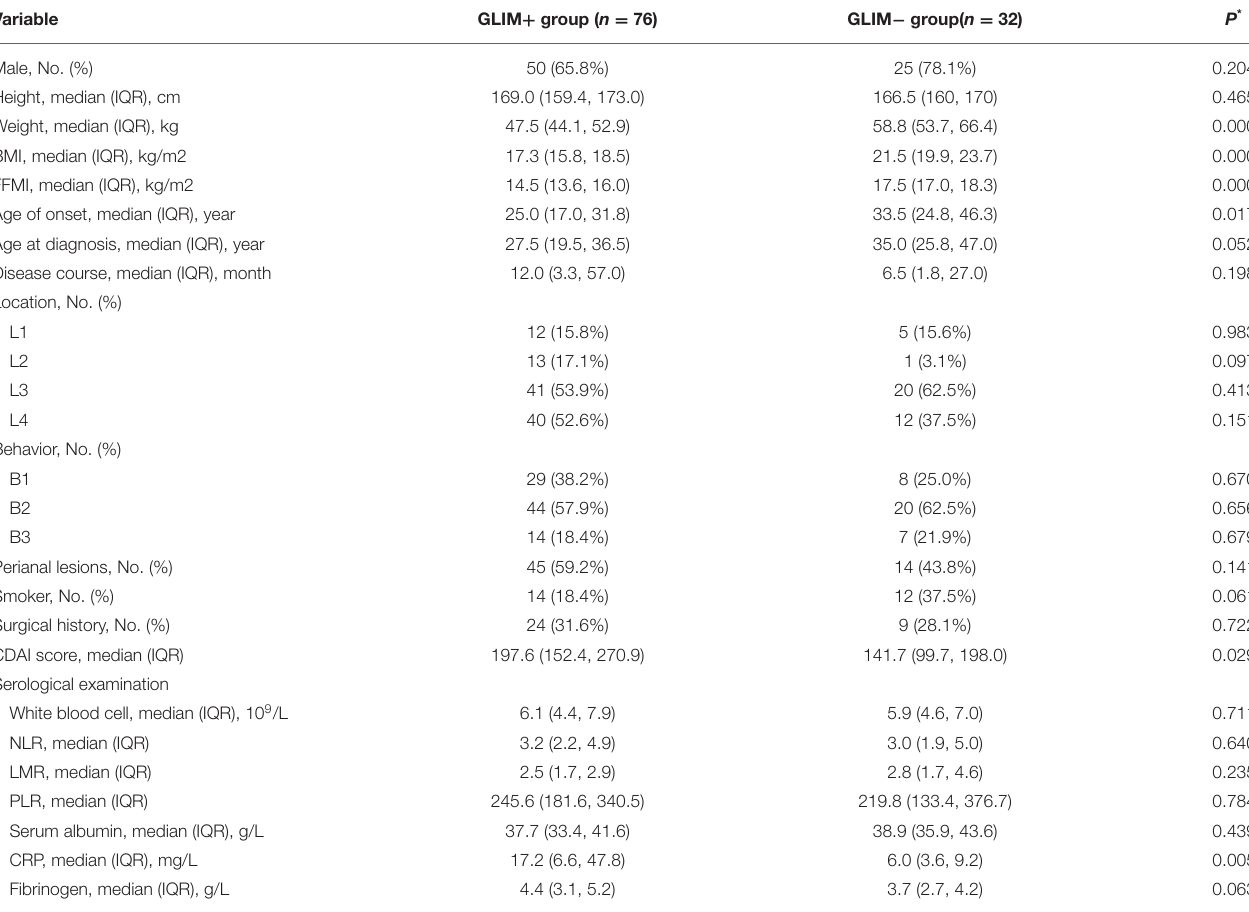
TABLE 4 | Comparison of patients according to the presence of malnutrition by GLIM criteria. Variable